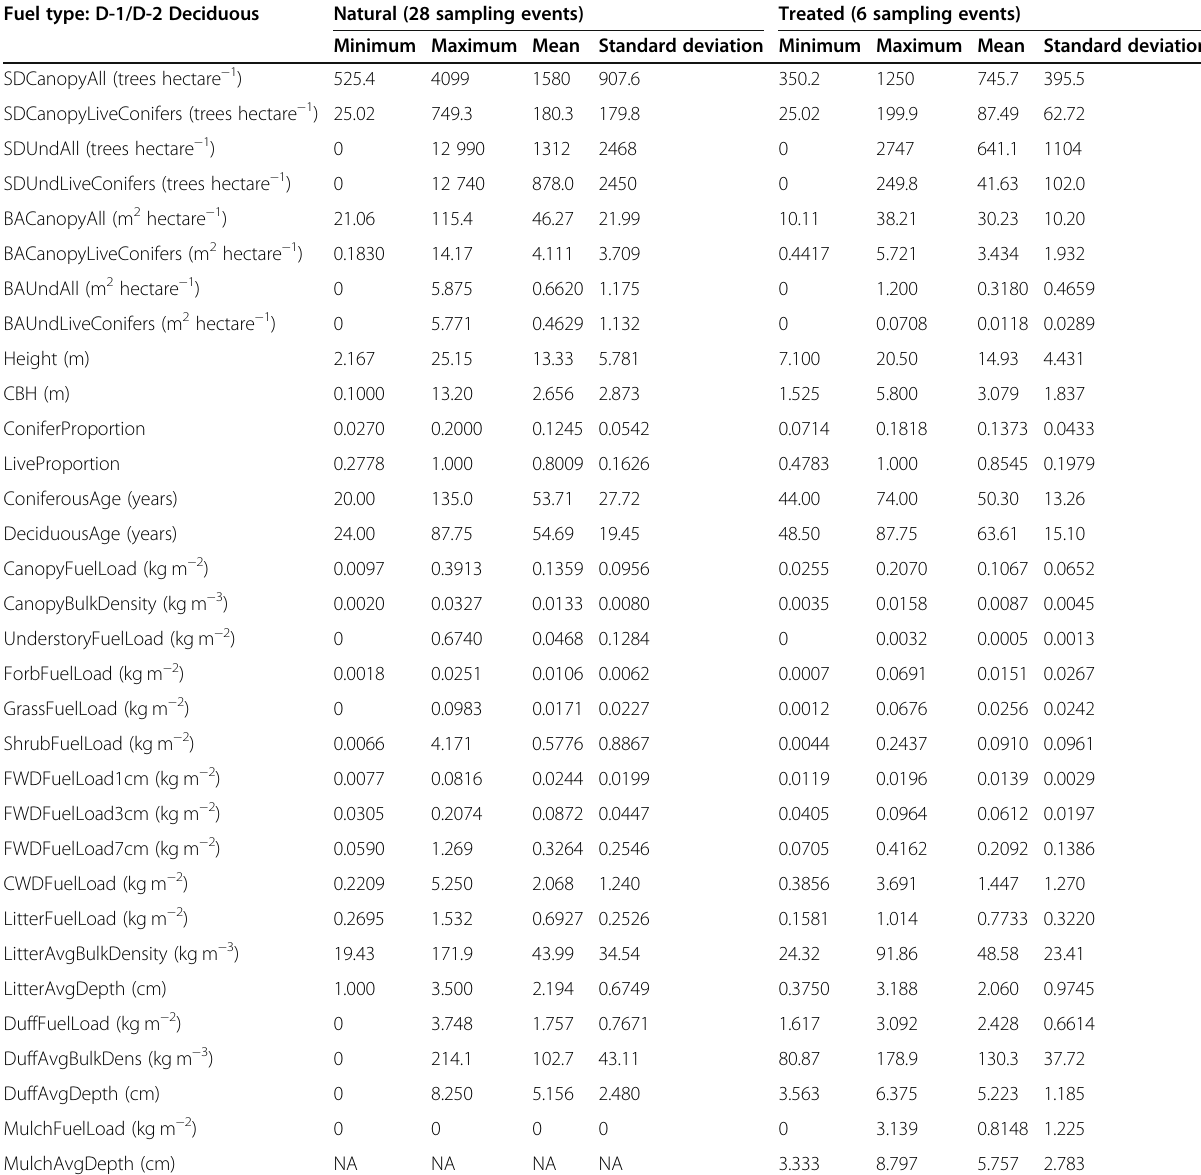
Table 6 Summary tables describing the minimum, maximum, mean, and standard deviation for several stand level features for each fuel type and treatment status by fuel type: D-1/D-2 Deciduous. It should be noted that the number of sampling events for each category is not necessarily the number of sampling events contributing to the computation. For example, a sampling event might not have any deciduous trees and therefore would not contribute to the computation of statistics about the age of deciduous trees. A value of NA indicates that there were zero — or possibly one in the case of standard deviation — sampling events contributing to the computation. Values were rounded to four significant figures, up to four decimal